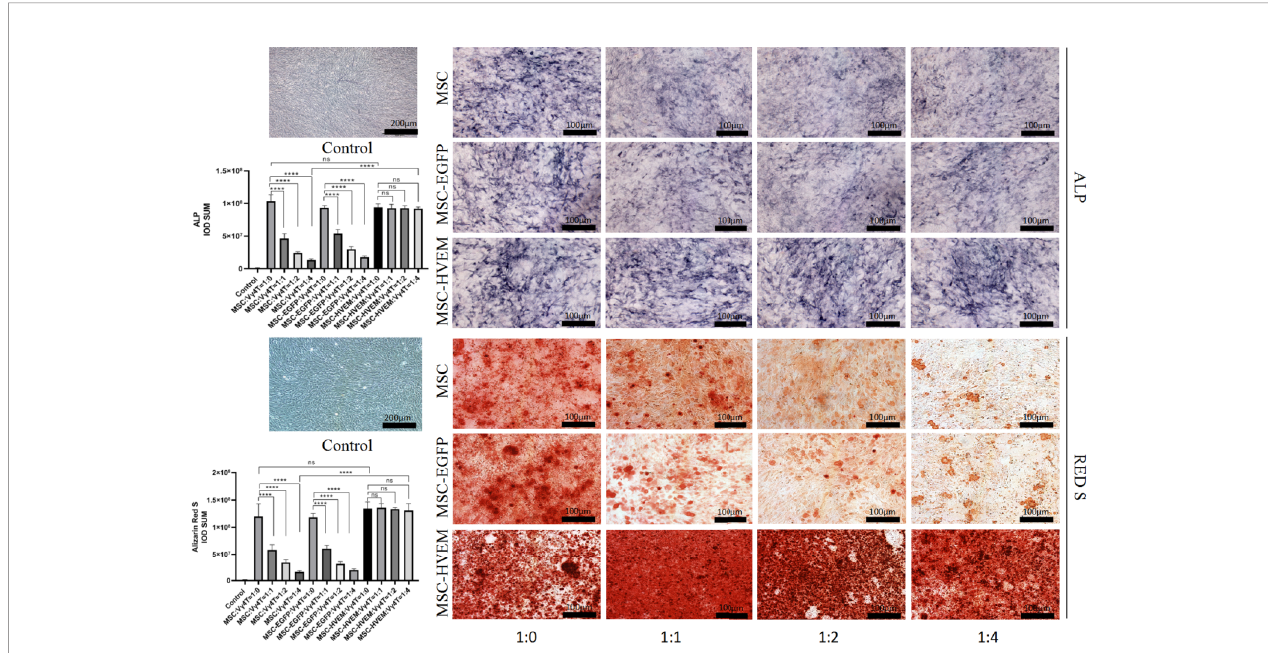
FIGURE 3 | V g 4T cells co-culture with MSCs or MSCs-HVEM then induced in osteogenic medium and ALP staining and alizarin red staining show various concentrations of V g 4T cells inhibited the osteogenic differentiation of MSCs but MSCs-HVEM could reverse the inhibition of V g 4T cells. Error bars represent mean ± SD. One-way ANOVA test was used to calculated P value (****P < 0.0001, ns P >